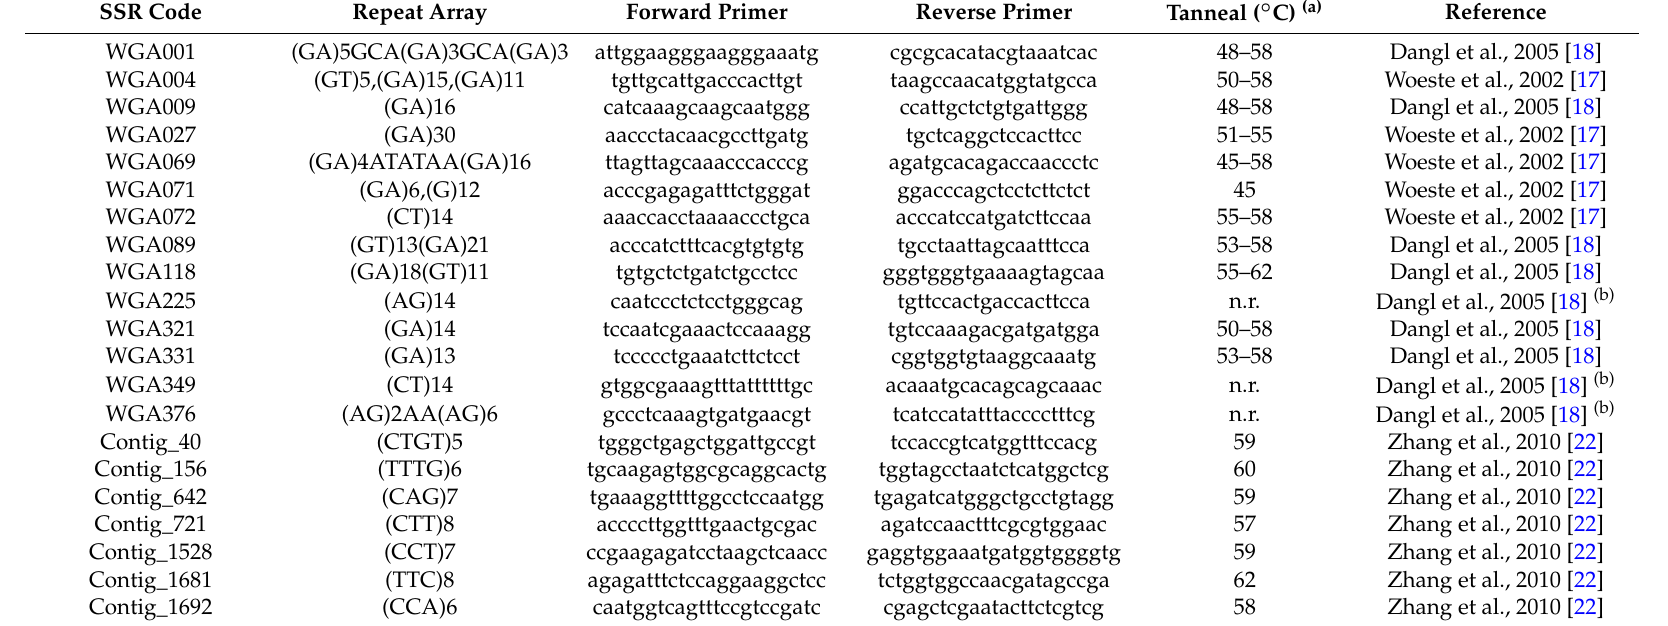
Table 1. List of the 20 Simple Sequence Repeat (SSR) markers selected from the literature for this